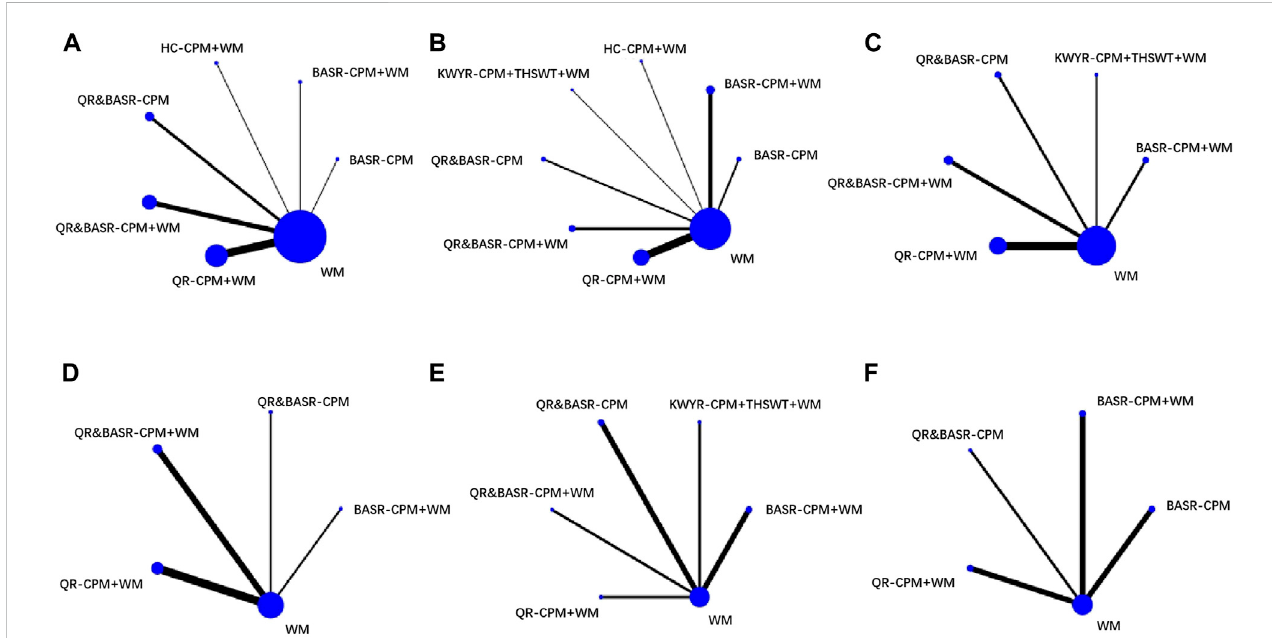
FIGURE 4 Network map. Notes: (A) : Clinical Ef fi cacy; (B) : LVEF; (C) : LVEDD; (D) : LVESD; (E) : LVMI; (F) : CRP; QR-CPM: Qi-replenishing Chinese patent medicine; BASR-CPM: Blood-activating and stasis removing Chinese patent medicine; HC-CPM: Heat-clearingChinesepatent medicine, KWYR-CPM: Kidney warming and yang-restoring Chinese patent medicine; QR&BASR-CPM: Qi-replenishing, blood-activating, and stasis-removing Chinese patent medicine; THSWT: TaohongSiwu decoction; WM: Western Medicine. The “ + ” sign indicated combined regimens.